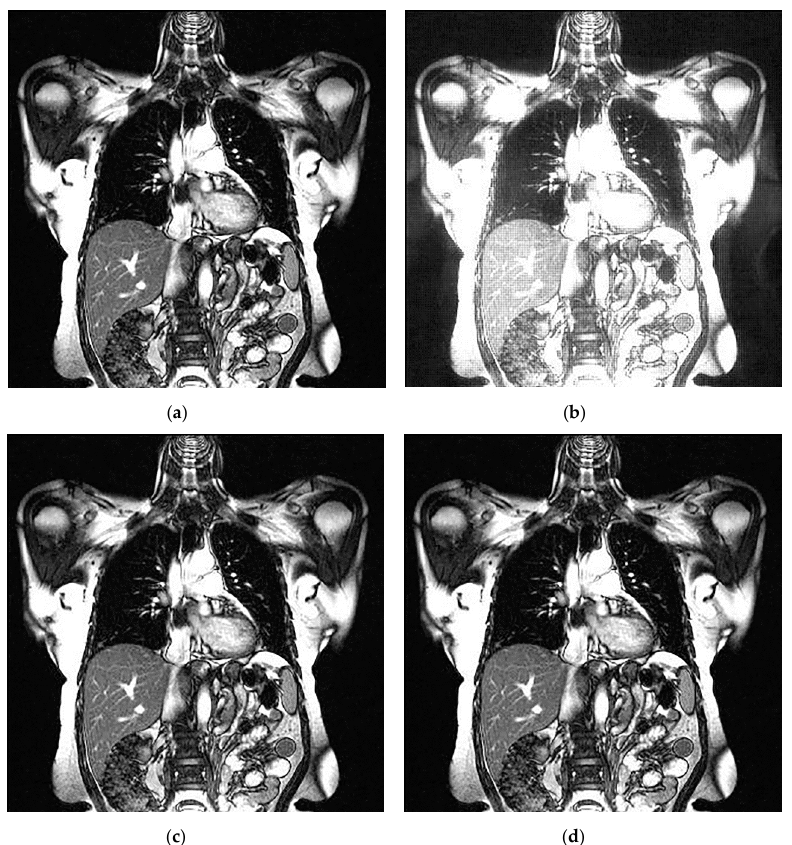
Figure 6. Example of 3D tomographic 12-bit image “Trufi_COR” (15-th frame) DWT by db 8 wavelet: ( a ) original image; processed image: ( b ) r = 7, PSNR = 30.27 dB; ( c ) r = 12, PSNR = 64.57 dB and ( d ) r = 17, PSNR = ∞ .